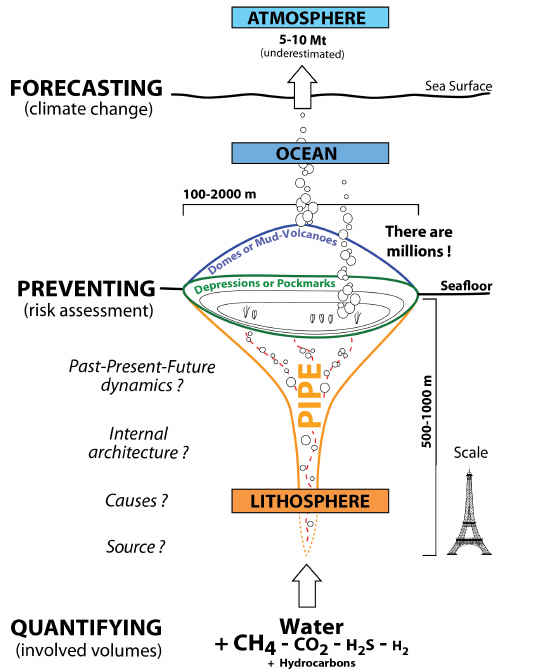
Figure 1: Sketch representing the challenges on fluid migration through pipes in sedimentary basins. From a physicist’s point of view, the host medium (lithosphere) can be viewed as liquid-saturated